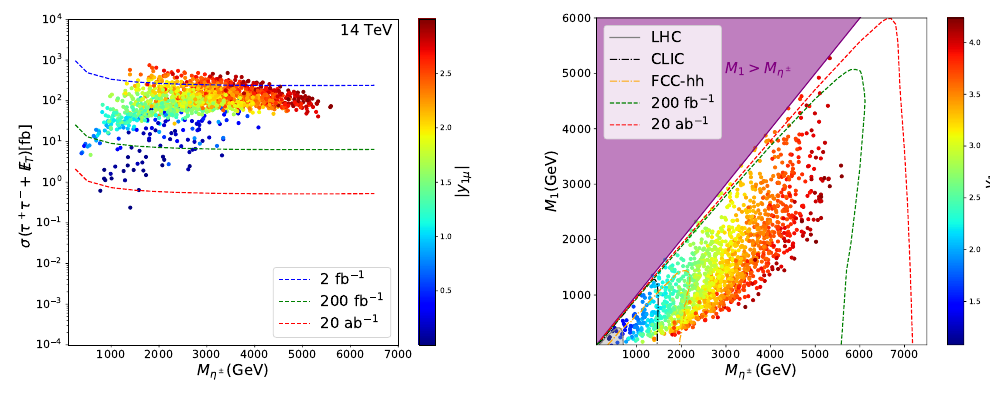
Figure 10 . Same as figure 8, but for the ditau